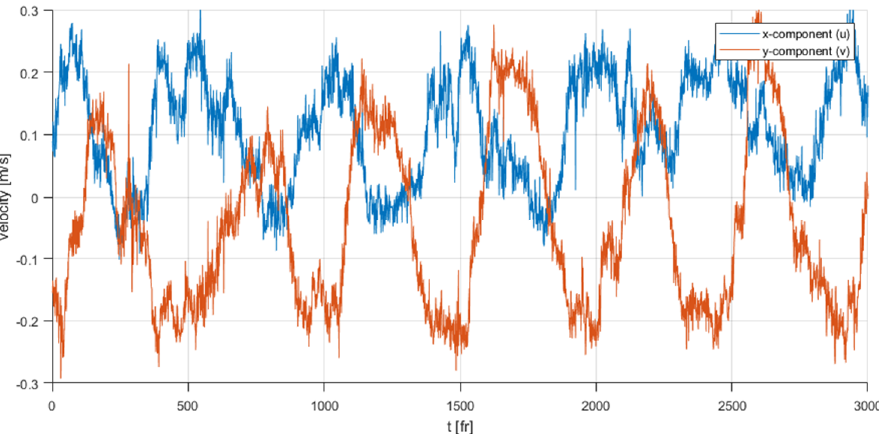
Figure 4. Time history of VP 1 showing oscillating behaviour. Data presented for 3000 frames.